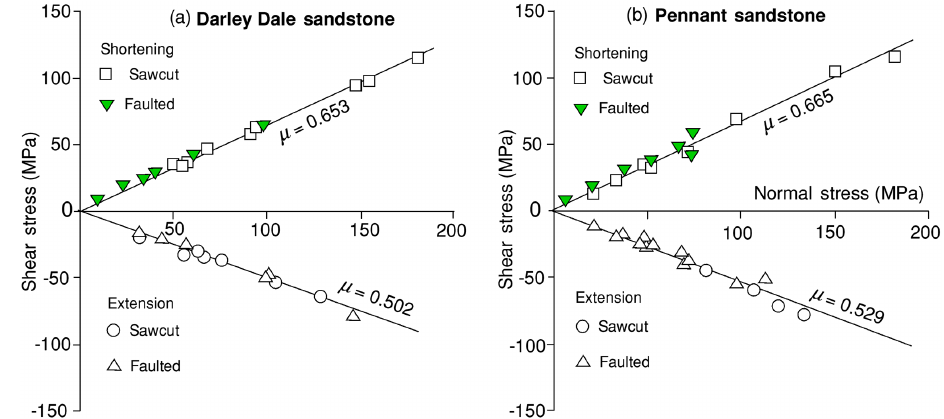
Figure 9. Frictional sliding data on saw cuts (including saw cut angles 35, 45 and 55 ◦ to the cylinder axis of the sample) and freshly faulted surfaces for Darley Dale and Pennant sandstones. For both rock types, friction coefficient in shortening is about 25% greater than in